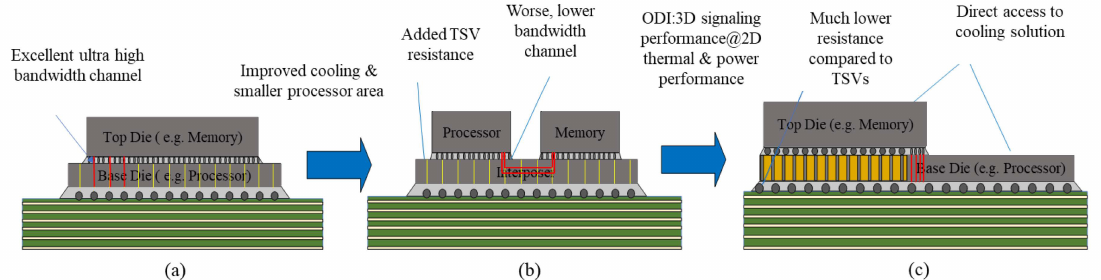
Figure 9. (a) 3D stacked processor and memory supporting large bandwidth but limited by TSV area increase & thermals; (b) solution of TSV & thermal problem using silicon interposer at the expense of reduced bandwidth and higher power; (c) ODI solution for supporting large bandwidth, good thermal performance and minimal TSV area increase. (reprinted from Ref. [52], Copyright 2019, with permission from